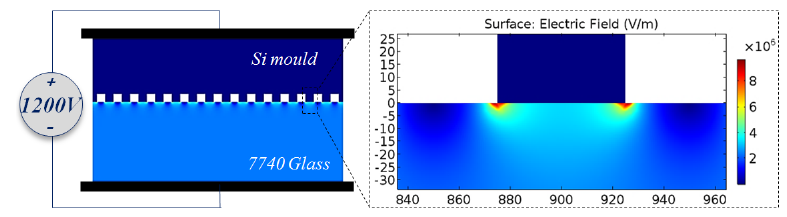
Figure 9. COMSOL electric field simulation for 50 μ m square pillar with 1200 V.